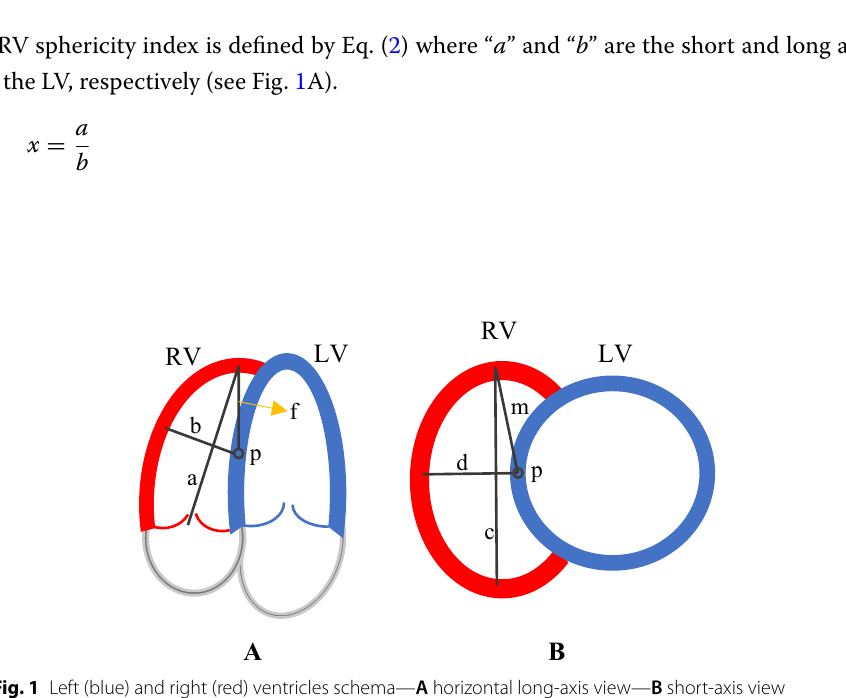
Fig. 1 Left (blue) and right (red) ventricles schema— A horizontal long-axis view— B short-axis